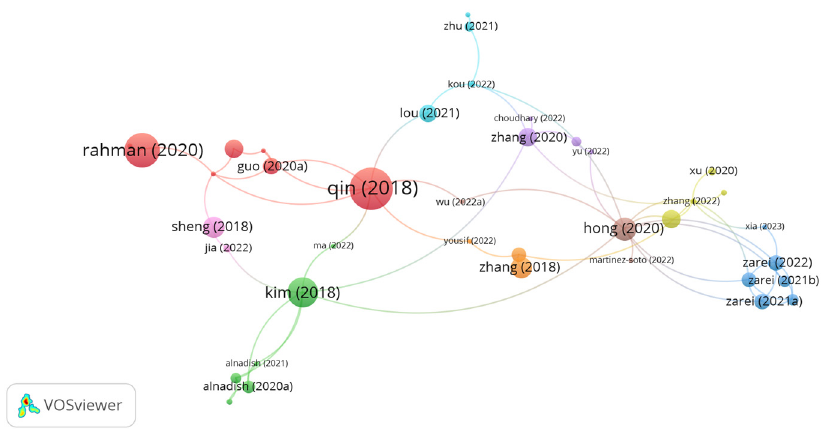
Figure 3. Network visualization of polyester fibers.